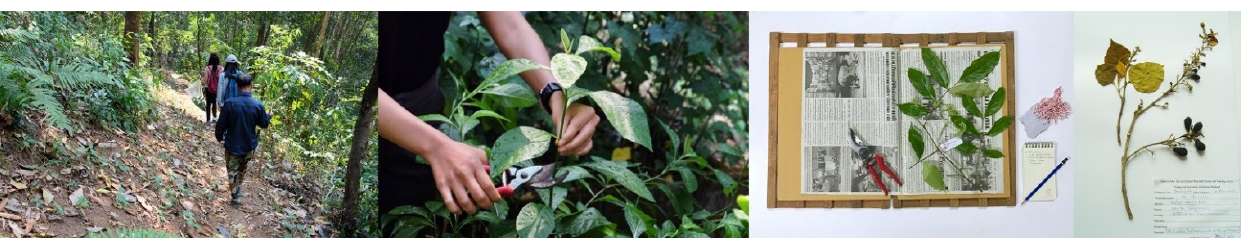
Figure 5. Ethnobotanical plant survey, collection, and preparation of voucher plant specimens.